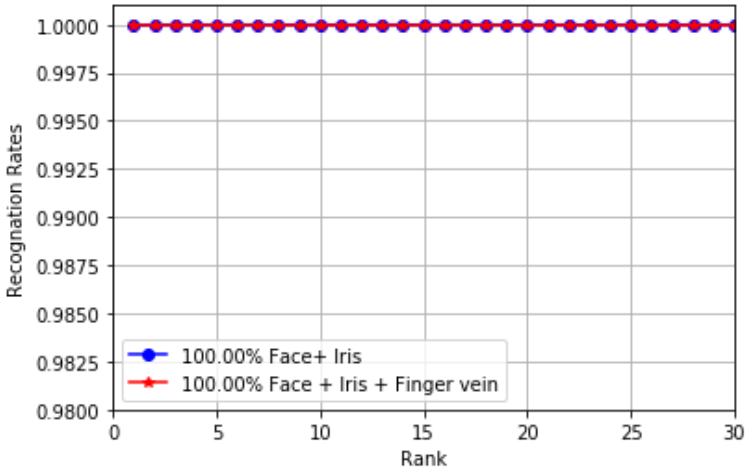
Figure 5. CMC curves for the multimodal models with the feature fusion method.